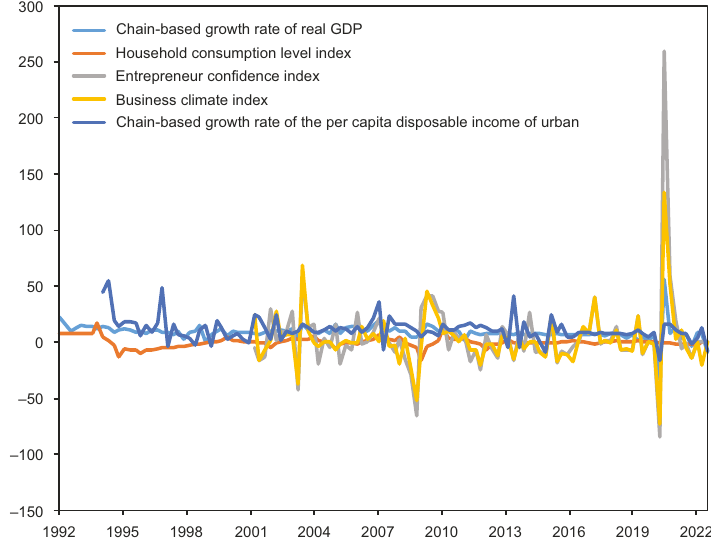
Figure D2. Trend graphs of fundamental factors on a quarterly